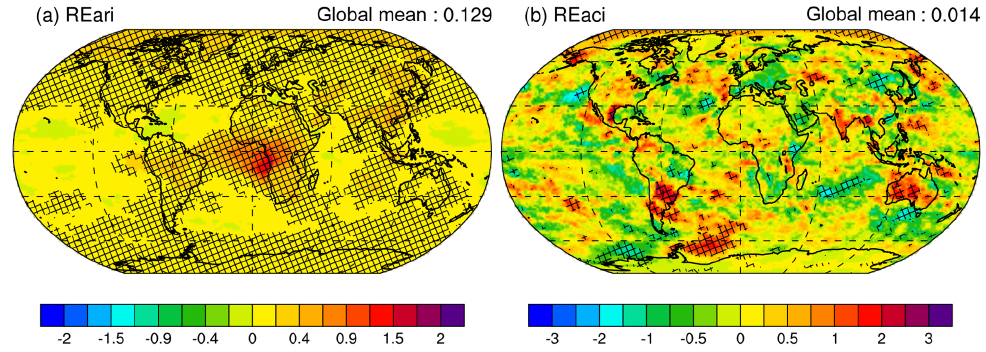
Figure 7. Radiative effects from (a) aerosol–radiation interaction (REari) and (b) aerosol–cloud interaction (REaci) from the BRC model run. Units are Wm − 2 . Note different scales. Hatching indicates regions where the change over the ensemble years is significant to the 0.05 (REari) and 0.1 (REaci)